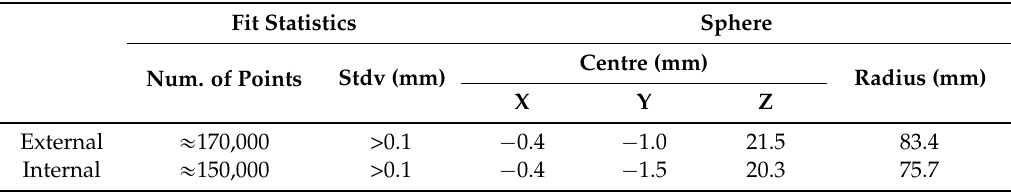
Figure 9. Reverse engineering of NI320 dome port: ( a ) opaque coating applied to avoid reflection and wrong measurements; ( b ) obtained polygonal model; ( c ) fitting of a sphere on the external dome surface. Table 3. Fitting of external and internal dome